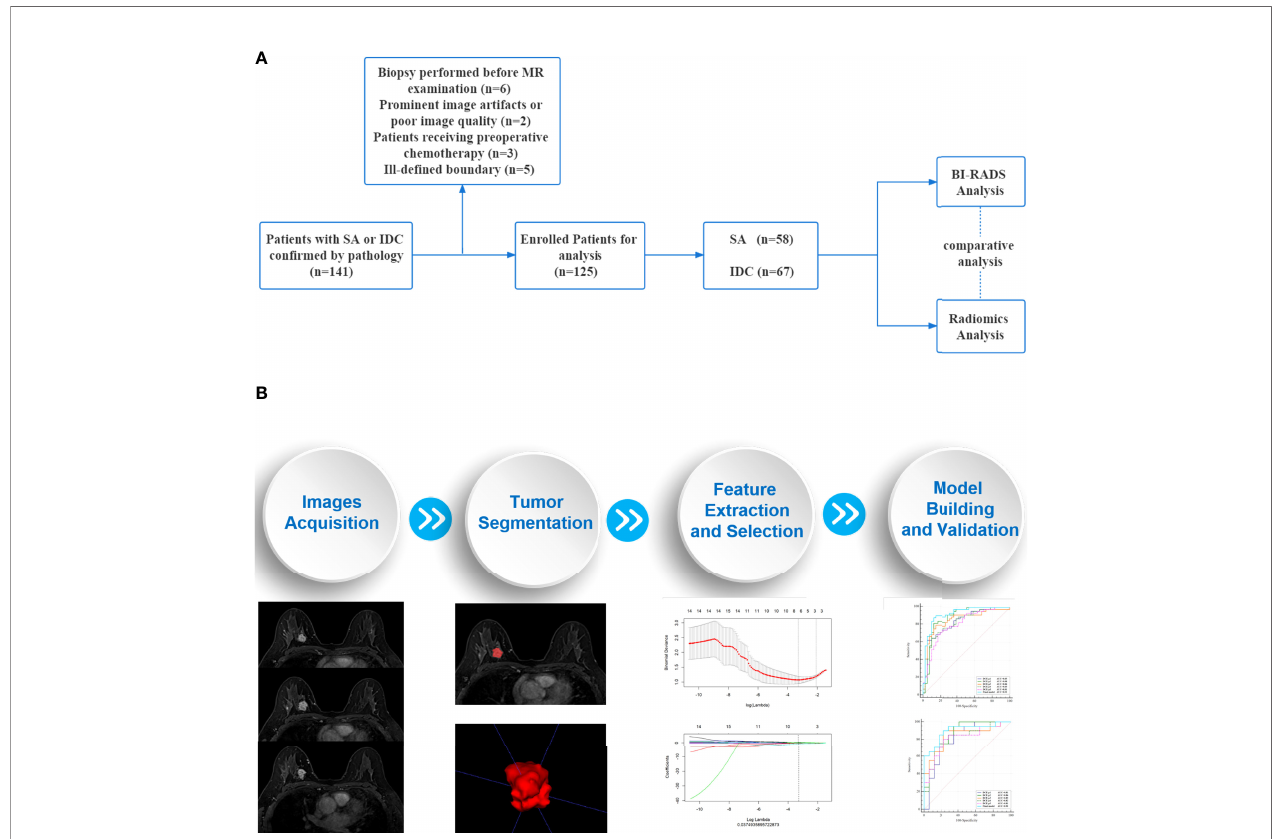
FIGURE 1 | Work fl ow of the study. (A) An overview work fl ow of the present study. (B) The process of radiomics analysis was mainly composed of four parts: images acquisition, tumor segmentation, feature extraction and selection, model building and